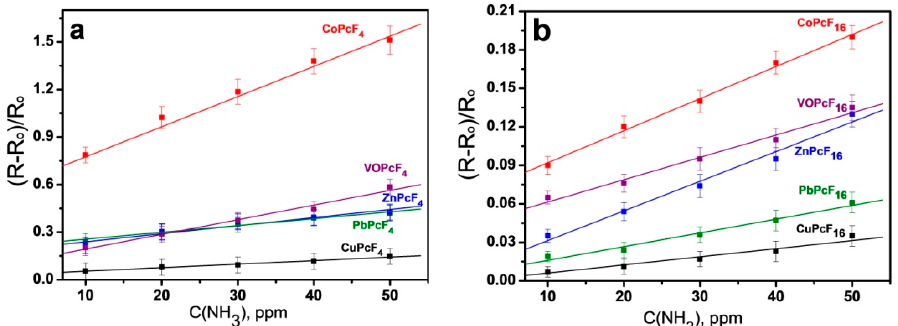
Figure 5. Dependence of the sensor response of MPcF x (M = Co, VO, Zn, Pb, Cu, x= 4 ( a ), 16 ( b )) films on ammonia